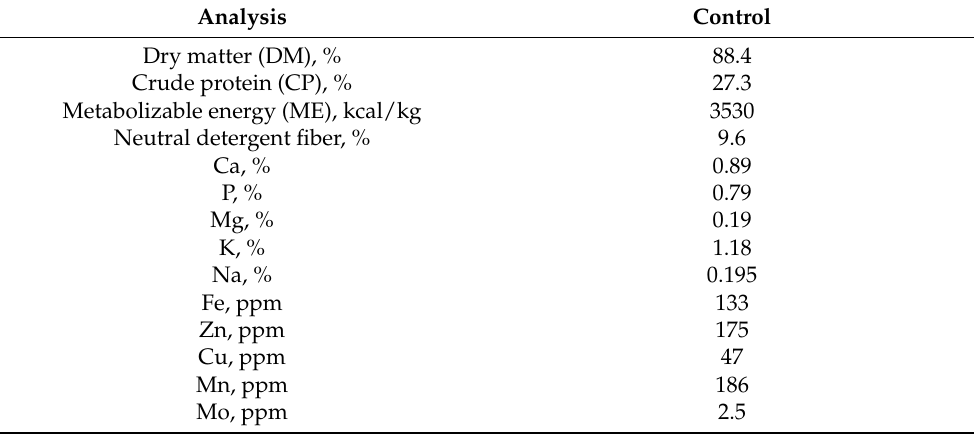
Table 2. Analyzed Nutrient Composition of Basal Diet (Dry Matter Basis) (Trials 1 and